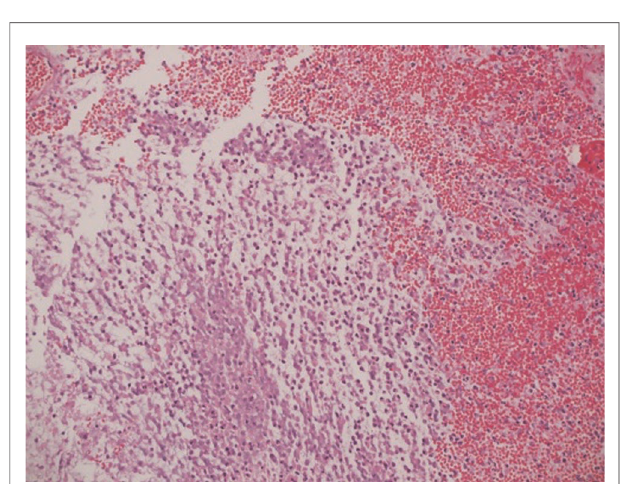
FIGURE 7 | Histopathology examination of the specimen showed astrocytoma with myxoid features suggestive of pilomyxoid astrocytoma with a background of hemorrhagic